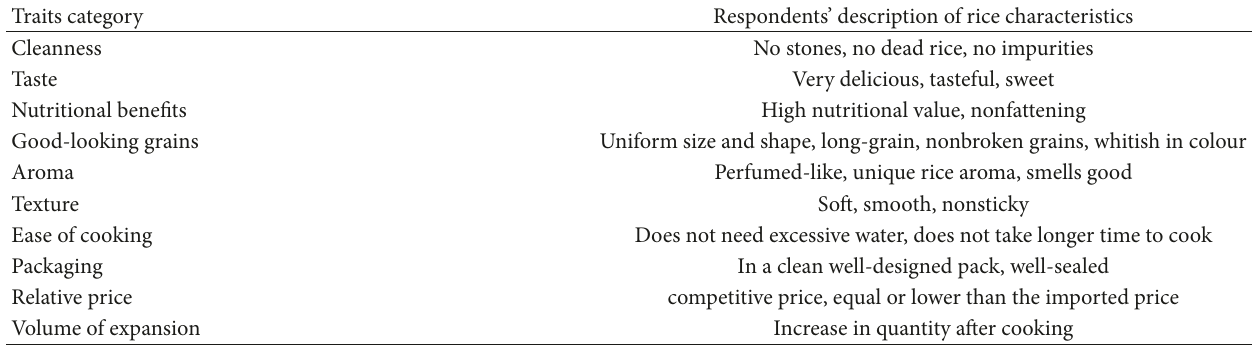
Table 1: Categories of Rice traits and their description elicited from the